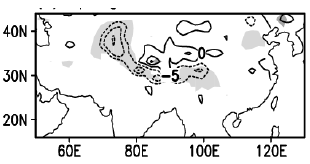
Figure 5. Epochal differences (2002–1994 minus 1982–1993) in snow cover over the Tibetan Plateau. Values exceeding the 95% confidence level are shaded. Figure 6. Regression upon snow cover index over the Tibetan